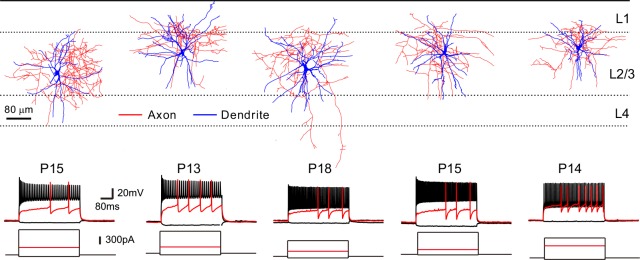
Morphologies of reconstructed FS-INs and corresponding evoked membrane responses.Top panel, the morphologic reconstructions of FS-INs. Bottom panel, the membrane responses of FS-INs to current injections.